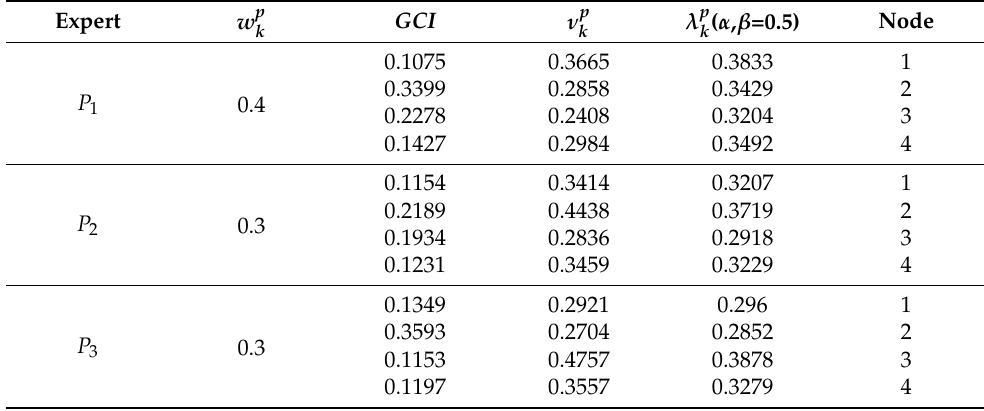
Table 17. Expert weights in the weighting